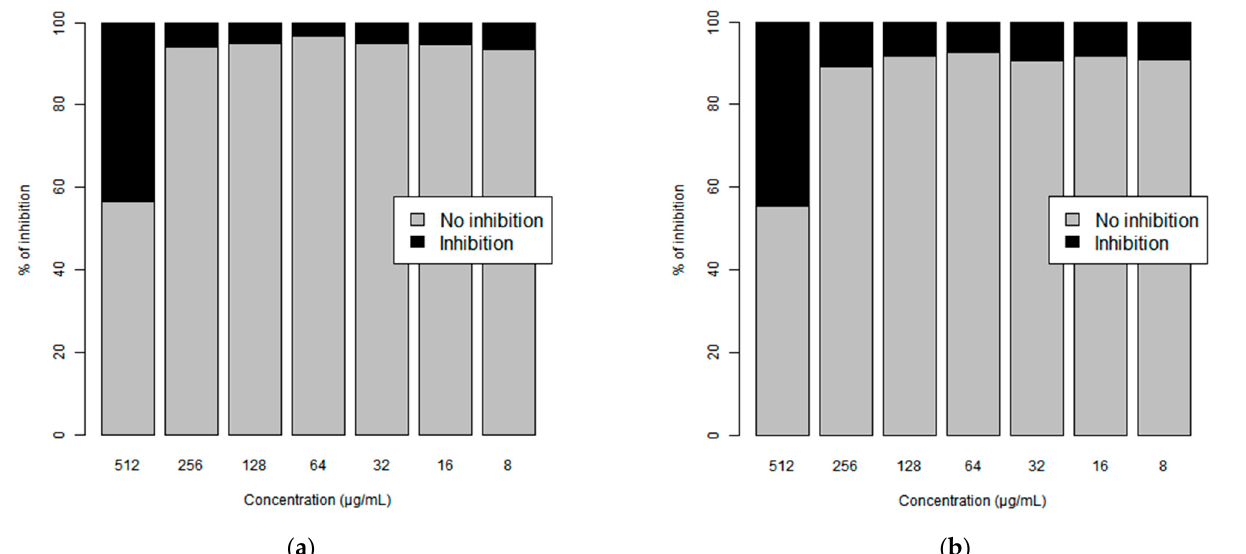
Figure 5. Estimated inhibition rate for strains ( a ) 1199 and ( b ) 1199B.